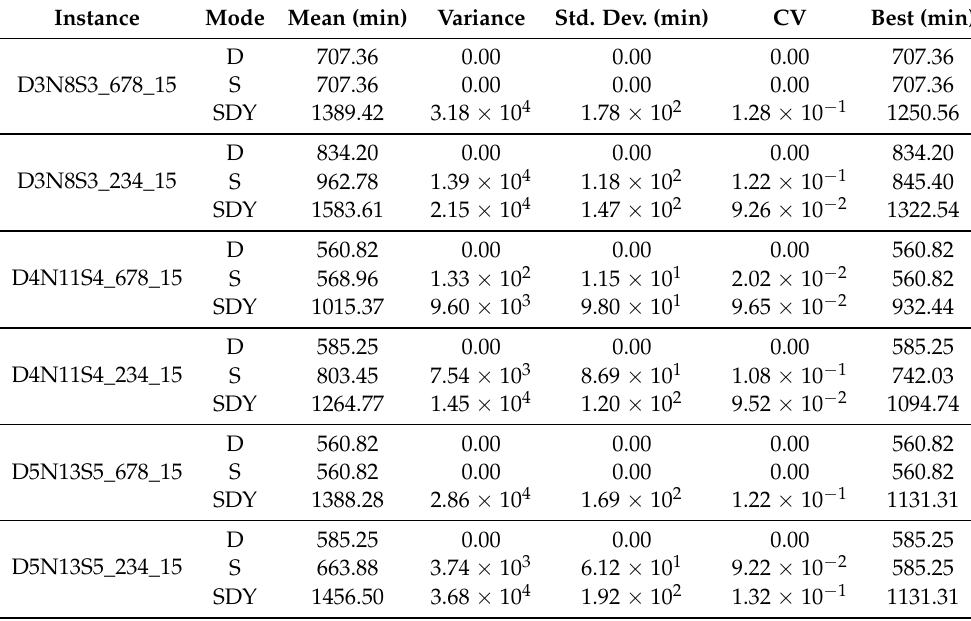
Table 6. Results of Total Travel Time with (Maximum) 15